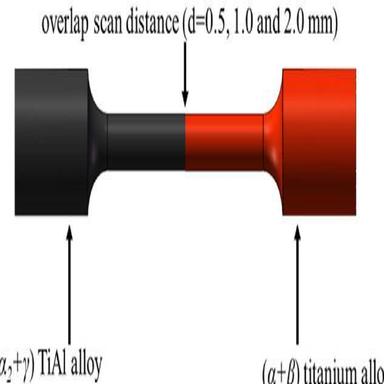
Schematic depicting the nominal dimensions of the tensile specimens produced.